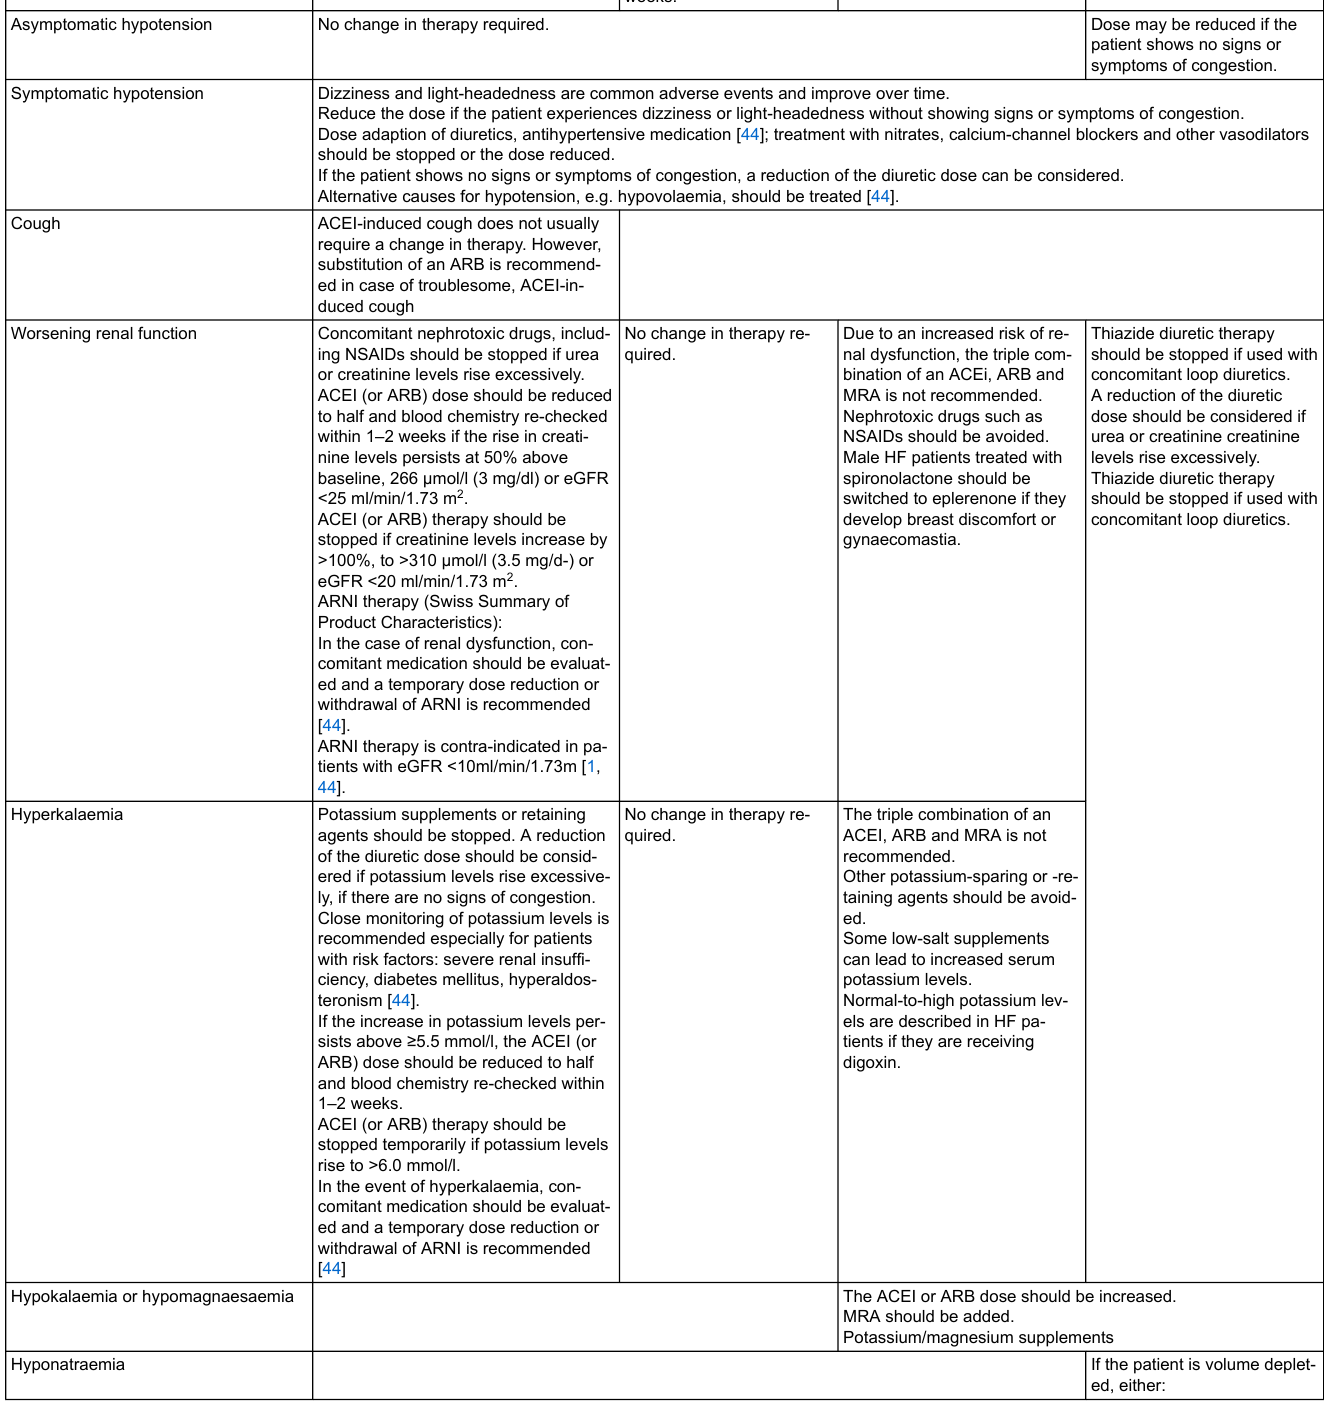
In patients with signs of in- creasing congestion, the di- uretic dose should be in-